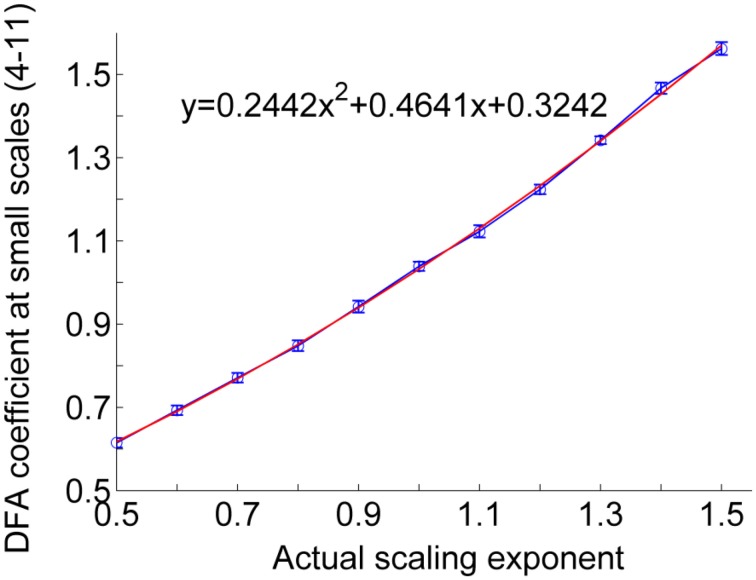
Relationship between actual scaling exponent α and DFA coefficient at scales between 4 and 11. The circles represent the mean values of DFA coefficients of 50 simulated monofractal signals with a length of 750 points. The lengths of the error bars represent the standard deviations. The fitting curve (red line) was computed in a least-squares sense.